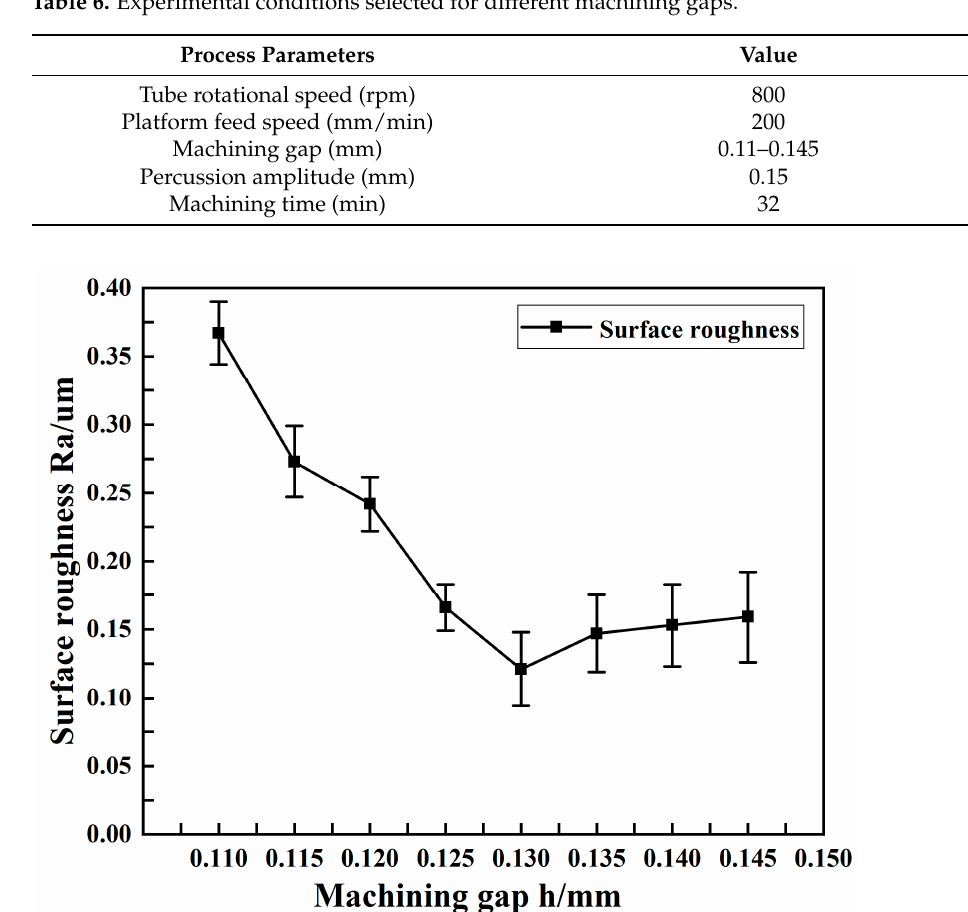
Figure 10. Effect of machining gap on surface roughness.